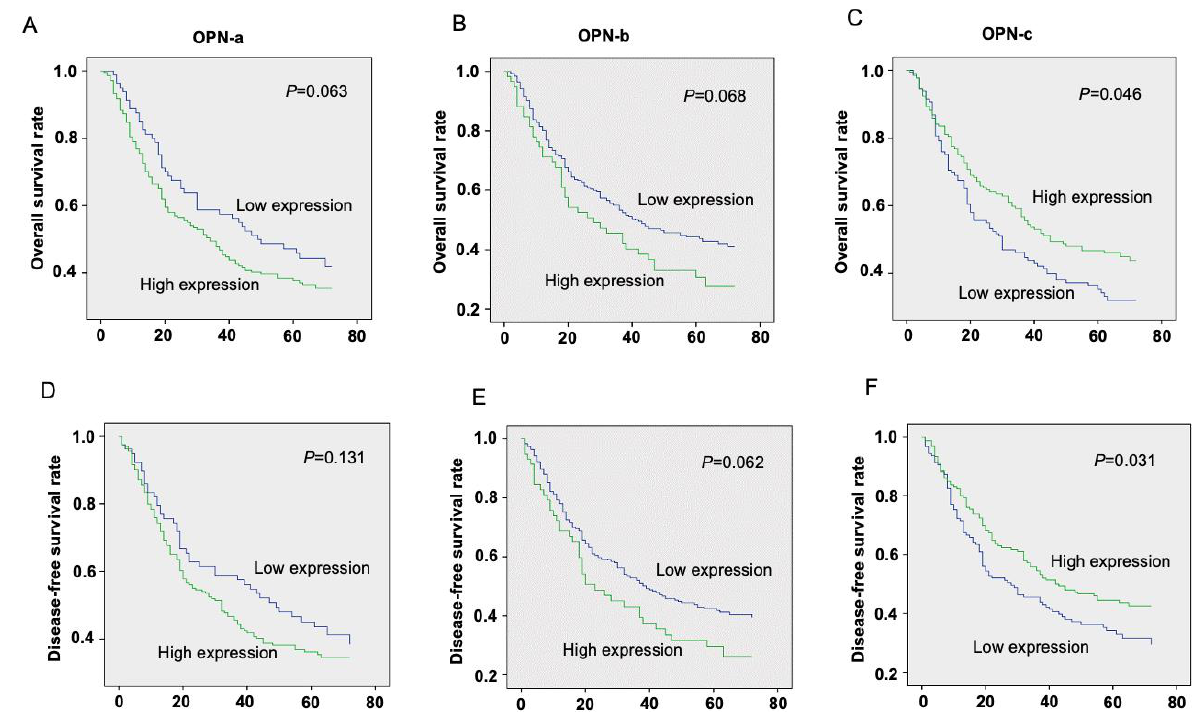
Figure 1. Prognosis values of OPN splice variants ’ expression in gastric cancer patients. The OS and DFS of the gastric cancer patients were positively associated with the overexpression of OPN-a ( A and D ) and OPN-b ( B and E ), individually. While decreased OPN-c expression was significantly associated with adverse pathology in gastric cancer ( C and F ).